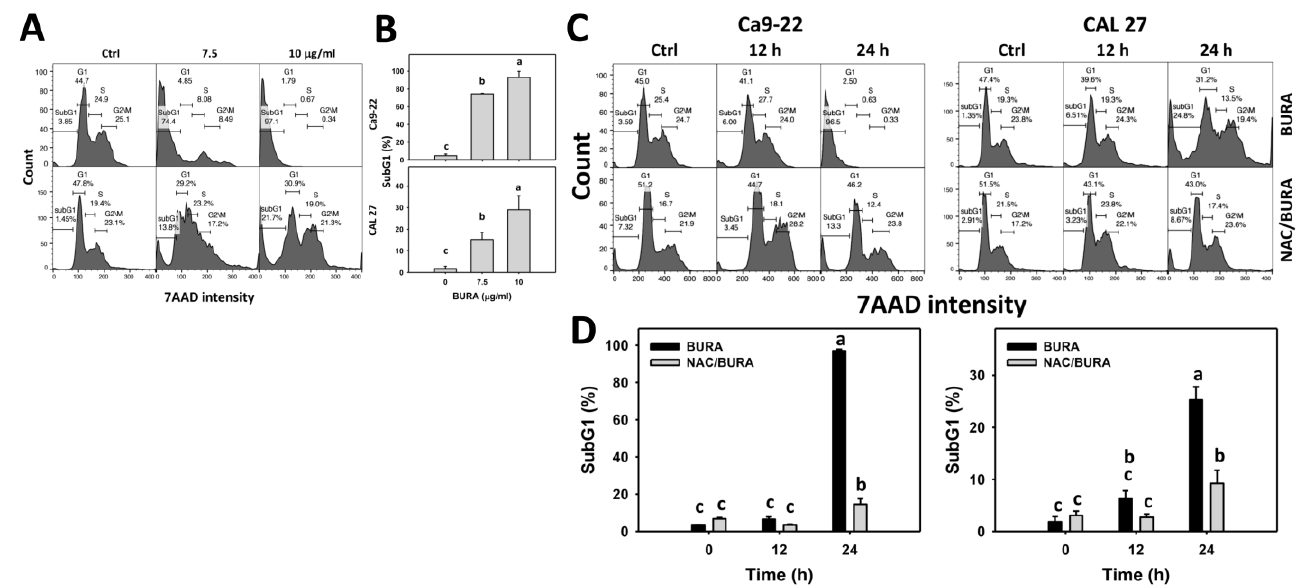
Figure 2. BURA causes cell cycle redistribution of oral cancer cells. ( A , B ) Cell cycle pattern and quantification. Oral cancer cells (Ca9-22 and CAL 27) were treated with BURA (control (0.1% DMSO), 7.5 µ g/mL (25.3 µ M), and 10 µ g/mL (33.8 µ M), 24 h). ( C , D ) NAC effect on cell cycle distribution and quantification. After NAC treatment (10 mM, 1 h), cells were treated with BURA (10 µ g/mL) for 0 (control), 12 and 24 h. They were labeled with NAC and NAC/BURA. Data, mean ± SD ( n = 3). Data top-labeled with non-overlapping lower-case letters differ significantly according to multi-comparisons of the same cell cycle phase ( p < 0.05).